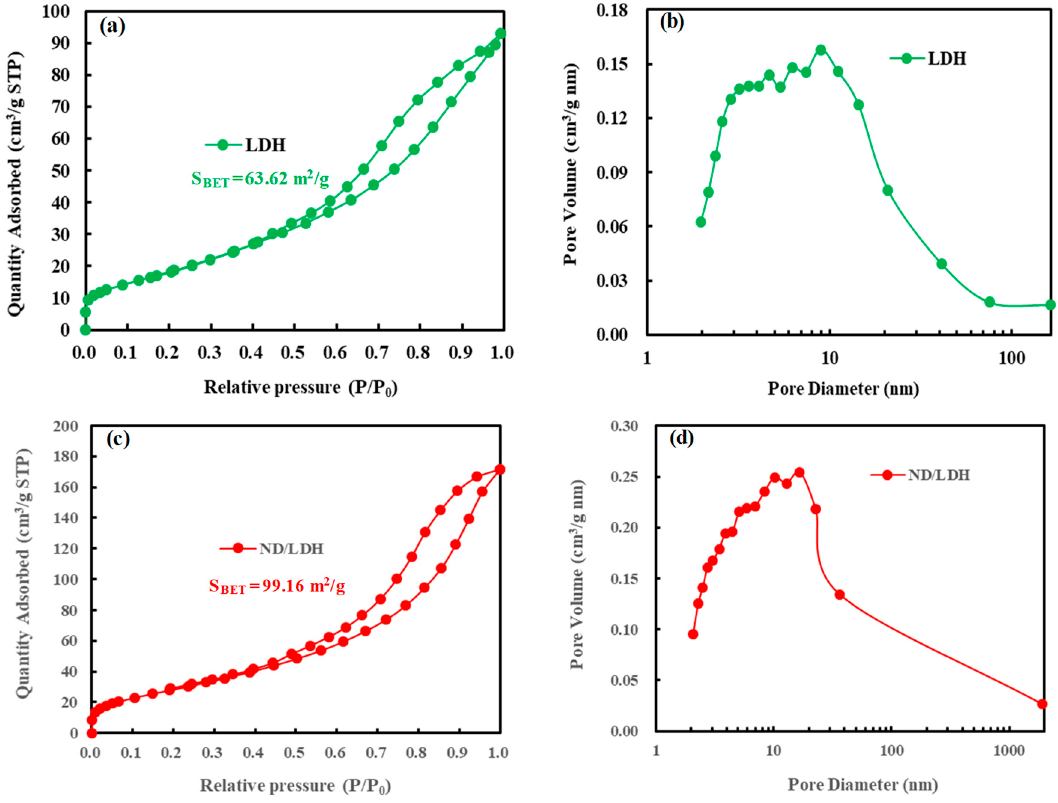
Figure 5. ( a ) Nitrogen adsorption-desorption isotherm of LDH; ( b ) Pore diameter distribution curve of LDH; ( c ) Nitrogen adsorption-desorption isotherm of ND/LDH; ( d ) Pore diameter distribution curve of ND/LDH.